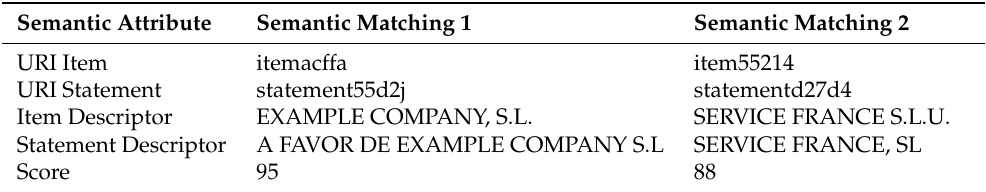
Table 9. Examples of highly scored semantic matching results obtained by the fuzzy search string similarity RapidFuzz algorithm.